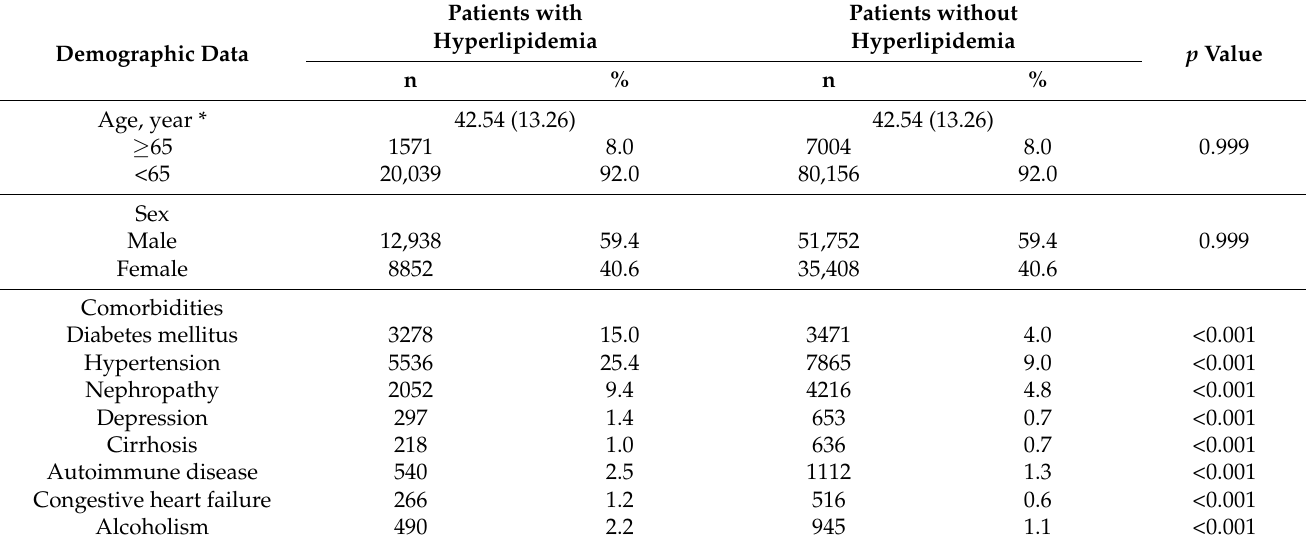
Table 1. Baseline characteristics of patients with and without